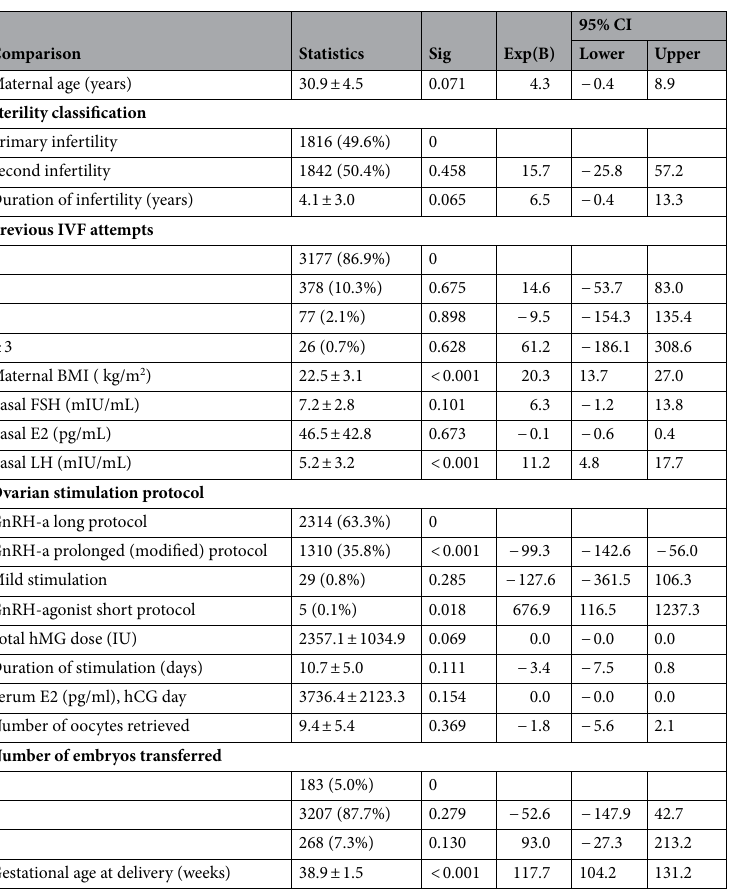
Table 2. Univariate analysis of neonatal birthweight. Outcome: Birthweight (g). Exposure: Maternal age (years); Sterility classification; Duration of infertility (years); Previous IVF attempts NEW; Maternal BMI (kg/ m 2 ); Basal FSH (mIU/mL); Basal E2 (pg/mL); Basal LH (mIU/mL); Ovarian stimulation protocol; Total hMG dose (IU); Duration of stimulation (days); Serum E2 (pg/ml), hCG day; Number of oocytes retrieved; Number of viable embryos; Number of embryos transferred; Gestational age at delivery (weeks); Serum E2 (pg/ml), hCG day; Oestradiol level (pg/mL) on trigger